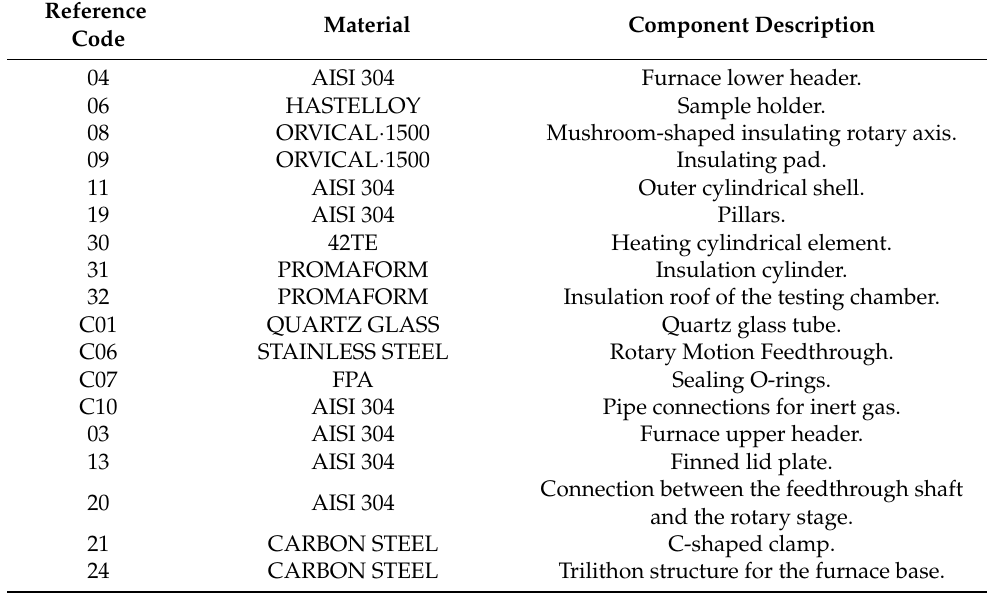
Table A1. List of the main components of the furnace prototype, divided into three groups: the furnace, the upper header and the base structure. A reference code allows the reader to identify each component when indicated within the text or in the